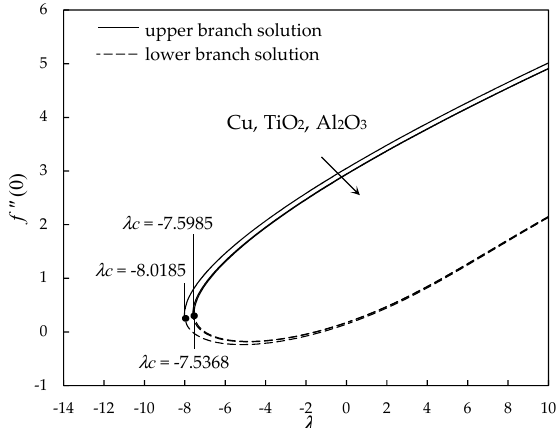
Figure 14. Variation of the reduced skin friction coefficient of f (cid:48)(cid:48) ( 0 ) with the mixed convection parameter λ when φ = 0.01, Nr = 0.1, K = 0.1, s = 1 and c = − 1 for Cu-water, Al 2 O 3 -water and TiO 2 -water nanofluids.